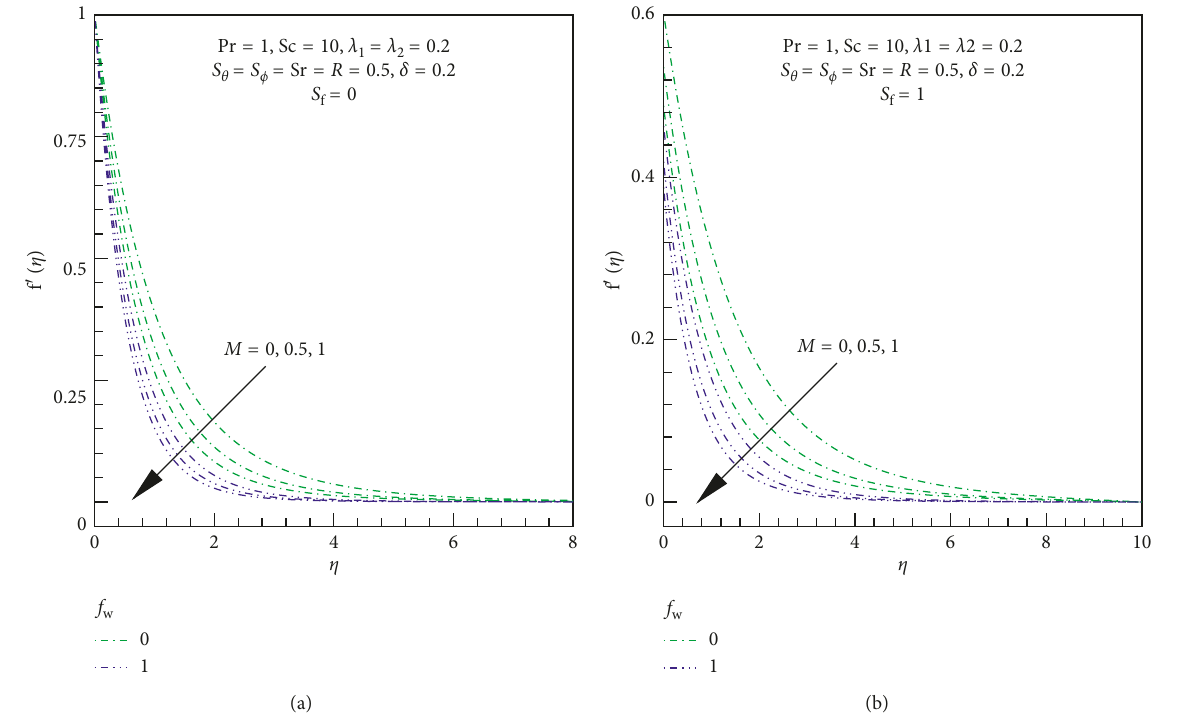
Figure 2: Effects of M and f w on dimensionless velocity. (a) No hydrodynamic slip. (b) With hydrodynamic slip.